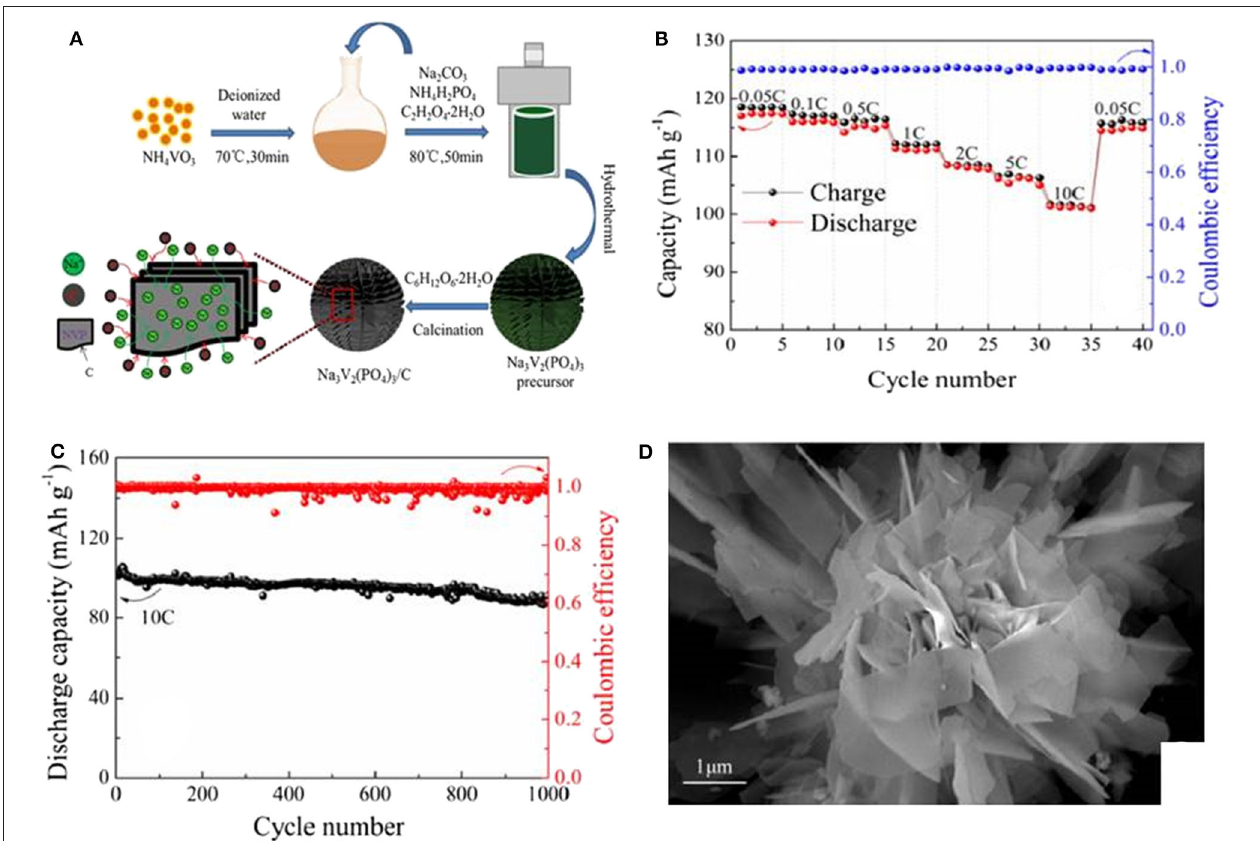
FIGURE 4 | (A) Schematic illustration ofthe fabrication of NVP/C materials, (B) rate performance of NVP/C, (C) cycle performance of the NVP/C cycled at 10C for 1,000 cycles, (D) SEM image of the NVP/C at 10C for 1,000